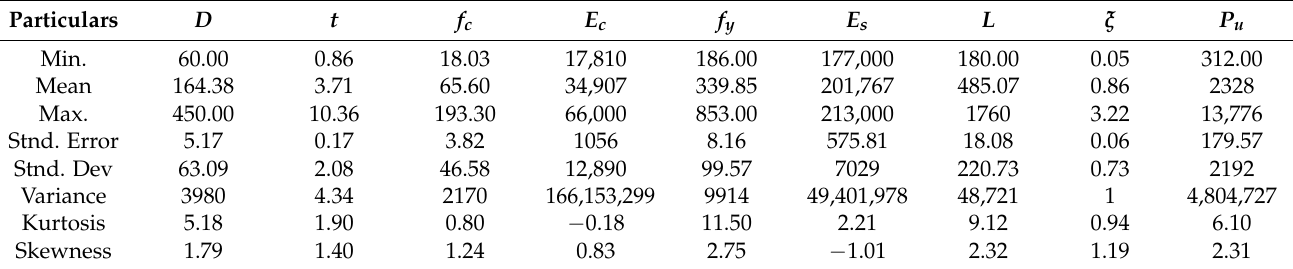
Table 1. Descriptive statistics of the employed